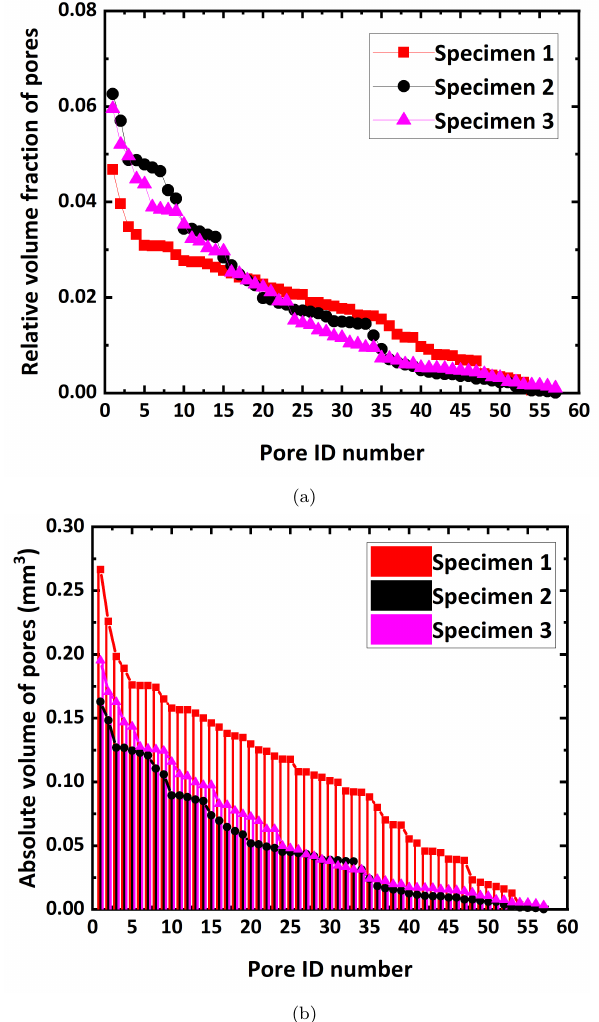
Figure 3. ( a ) Relative volume fraction (RVF) of pores, and ( b ) absolute volume (AV) of pores in the microstructures, as shown in Figure 2. Table 3. Summary of microstructural features of various model domains with different strut thickness, as shown in Figure 4. Thinner Standard